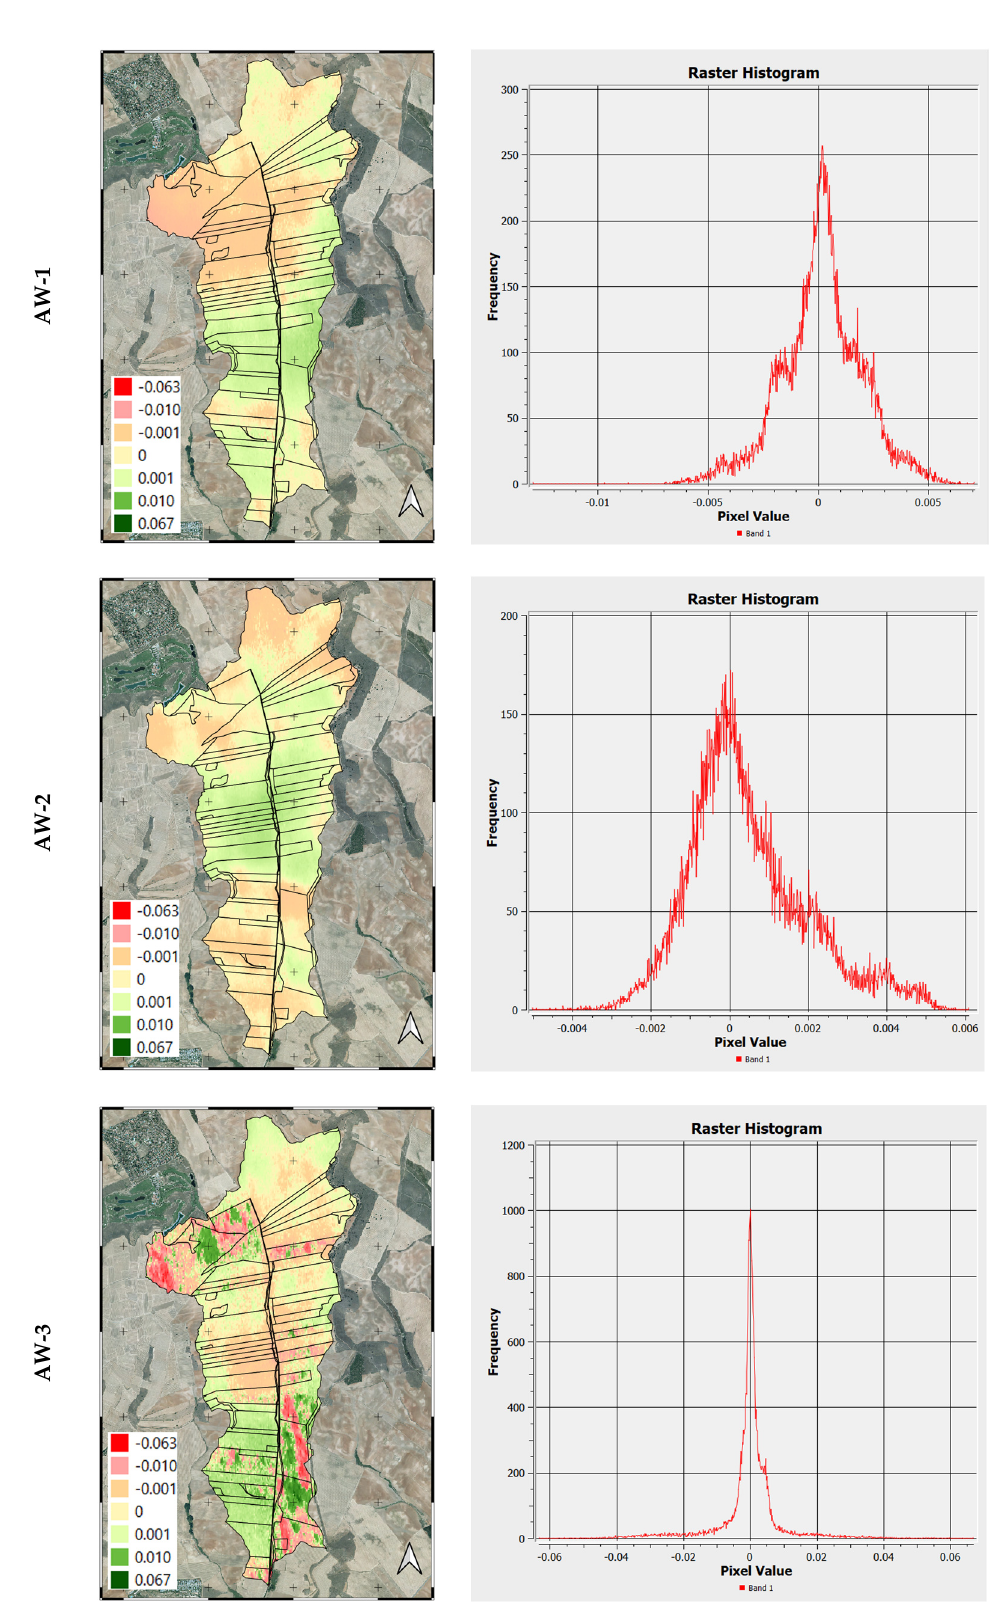
Figure 8. Corrected deformation raster in metres (m) for scenario AW-1 (15–27 June 2017), AW-2 (17–29 June 2019), and